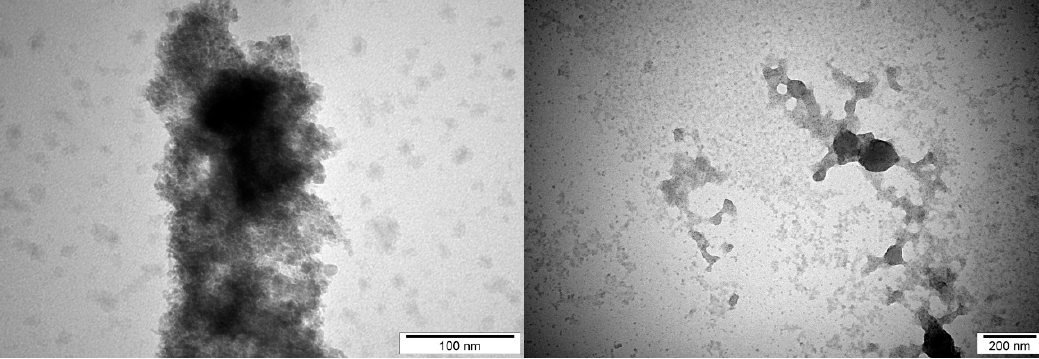
Figure 10. Transmission electron microscope photographs of CuNPs.